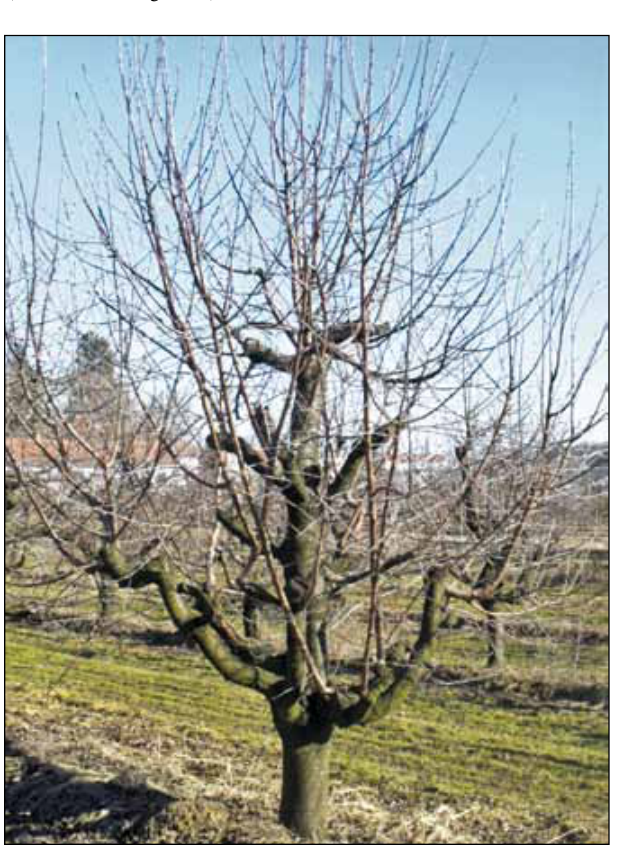
Figure 4. Fruit size of the control and rejuvenated sour cherry trees (Debrecen – Pallag,